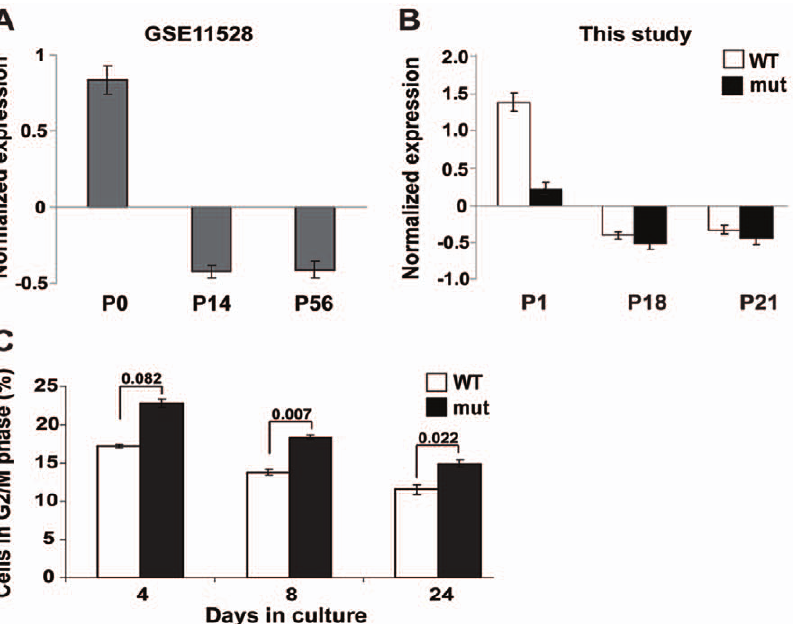
Figure 2. Expression of cell cycle-related genes. Average expression patterns of the 44 cell cycle-related genes with lower expression level in mutant mice at P1 (see Materials and Methods). (A) Expression during normal mouse brain development according to the measurements in [19].(B) Expression according to the current study. The expression pattern of each gene was normalized to mean=0 and standard deviation=1. The average expression of the genes in all replicates is shown for each time point. Error bars represent one standard error. (C) Primary astrocytes were isolated from wild-type (WT) and mutant (mut) mice brains at P1. Following 4, 8 and 24 days in culture, the cells were subjected to flow cytometry analysis using propidium iodide for DNA staining. The precentage of cells in G2/M phase is shown for wild-type (WT, white) and mutant (mut, black) primary astrocytes, representing the average of 3 independent experiments. t-test p values are indicated.